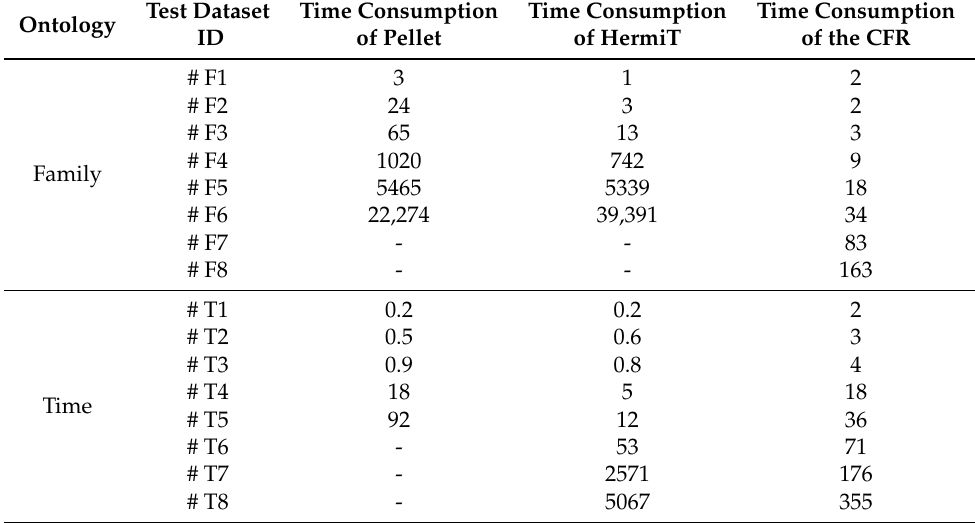
Table 7. Time consumption of the CFR and ontology reasoners on independent synthetic test datasets.